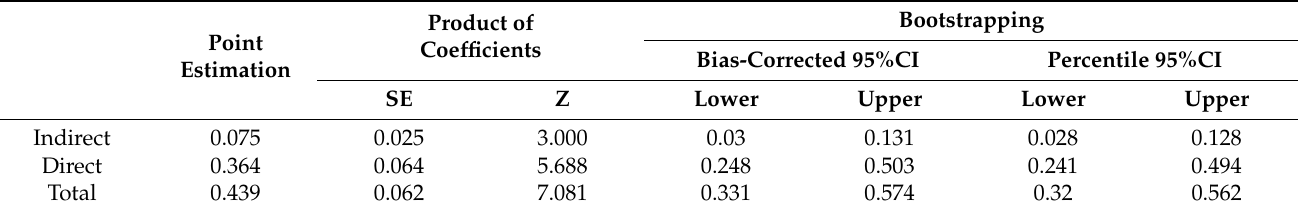
Table 6. Mediation of effect of model.